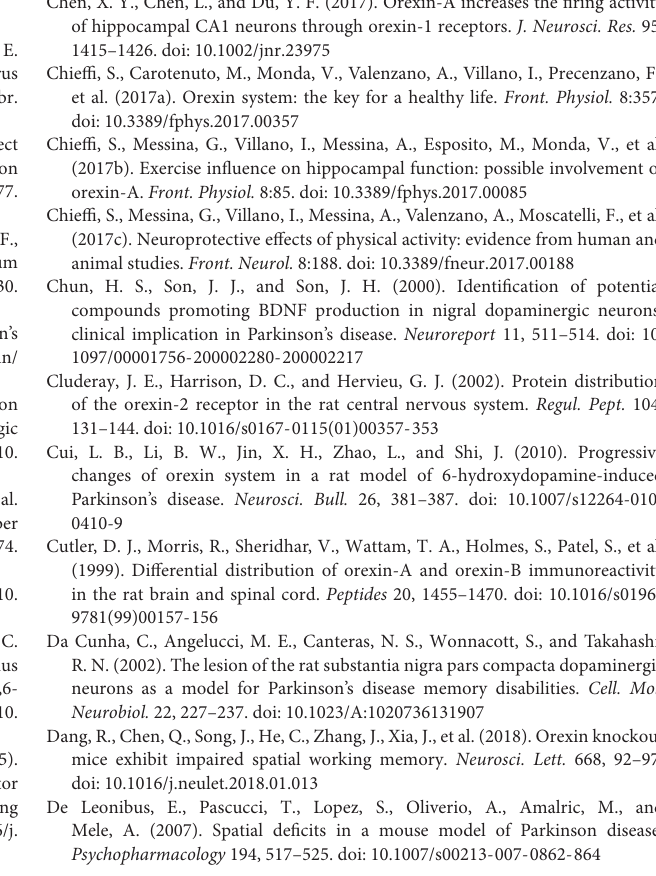
FIGURE S4 | The original image for the bands of β -actin in Figure 7A . After the staining of BDNF, the membrane was used for the detection of β -actin. Because of the antigen cross reaction, besides the bands of β -actin, the bands of BDNF were also detected in the membrane. FIGURE S5 | Relative position for the protein bands of OX1R, β -actin, pro BDNF and mature BDNF. The four protein bands are drawn from the same gel. The PVDF membrane was split into two parts for the detection of different proteins. The central bands in the picture were selected to be shown in Figure 7A . FIGURE S6 | The original image for the bands of PI3K in Figure 8B . This membrane includes the protein above 50 kDa. The membrane was used for the detection of PI3K, which has a relative molecular weight of 85 kDa. FIGURE S7 | The original image for the bands of TH in Figure 8B . This membrane with proteins above 50 kDa was also used for the detection of TH. The relative molecular weight of TH is 55 kDa. FIGURE S8 | The original image for the bands of β -actin in Figure 8B . The membrane with proteins between 40 kDa and 50 kDa was used for the detection of β -actin, which serving as a loading control. FIGURE S9 | The original image for the band of BDNF in Figure 8B . The membrane containing proteins less than 40 kDa was used for the detection of BDNF. FIGURE S10 | The original image of Figure 8B . The protein bands of PI3K, TH, BDNF, and β -actin are from one gel. To make the bands concise and potent, we deleted several parallel bands in the center (three bands in orexin-A alone group and one band in orexin-A plus LY294002 group) and two irrelevant bands at the right side. The deleted areas have been pointed out by red